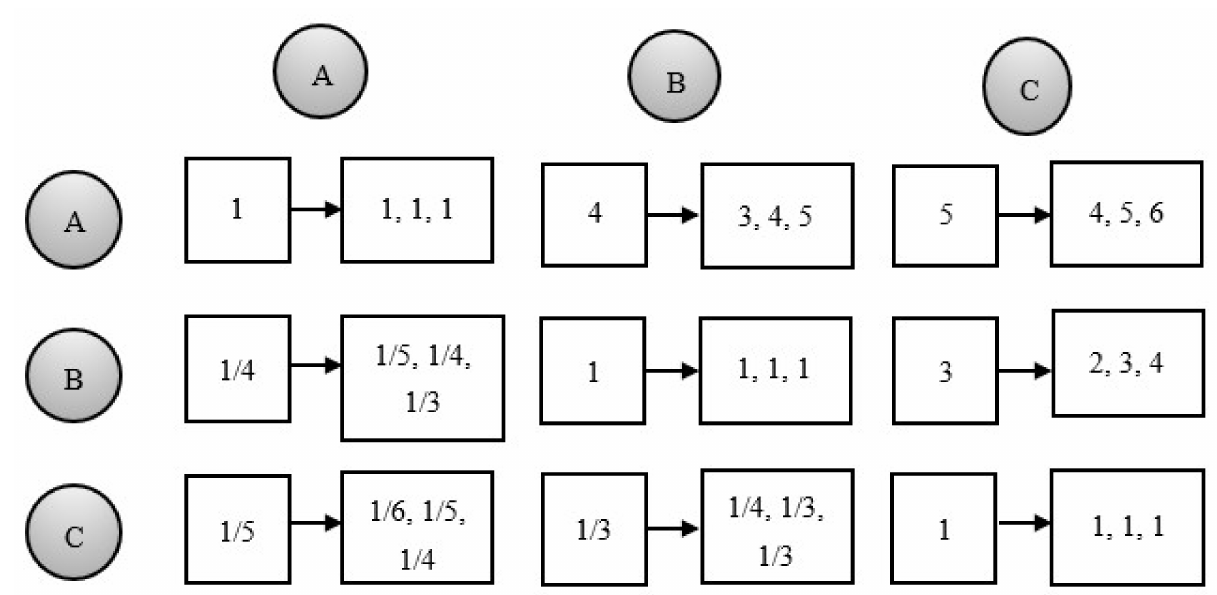
Figure A1. Transformation of AHP scores into equivalent TFNs.